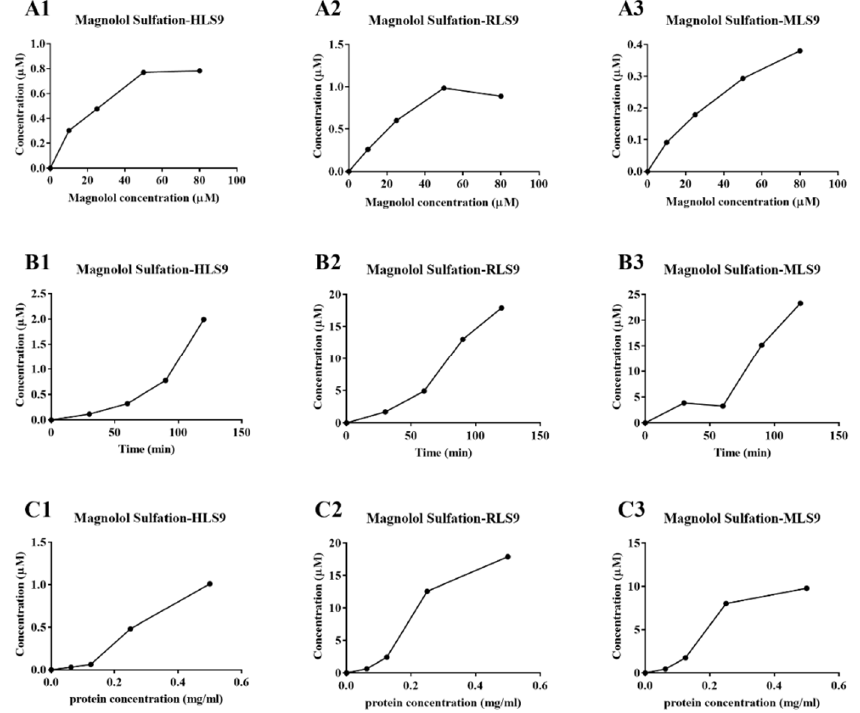
Figure 2. Substrate concentration ( A1 – A3 ), incubation time ( B1 – B3 ), and protein concentration ( C1 – C3 )—dependent incubation studies of magnolol sulfation metabolism in the liver S9 fractions from different species (HLS9, RLS9, and MLS9). Each point represents an average of three determinations, and the error bar is the standard deviation of the mean.